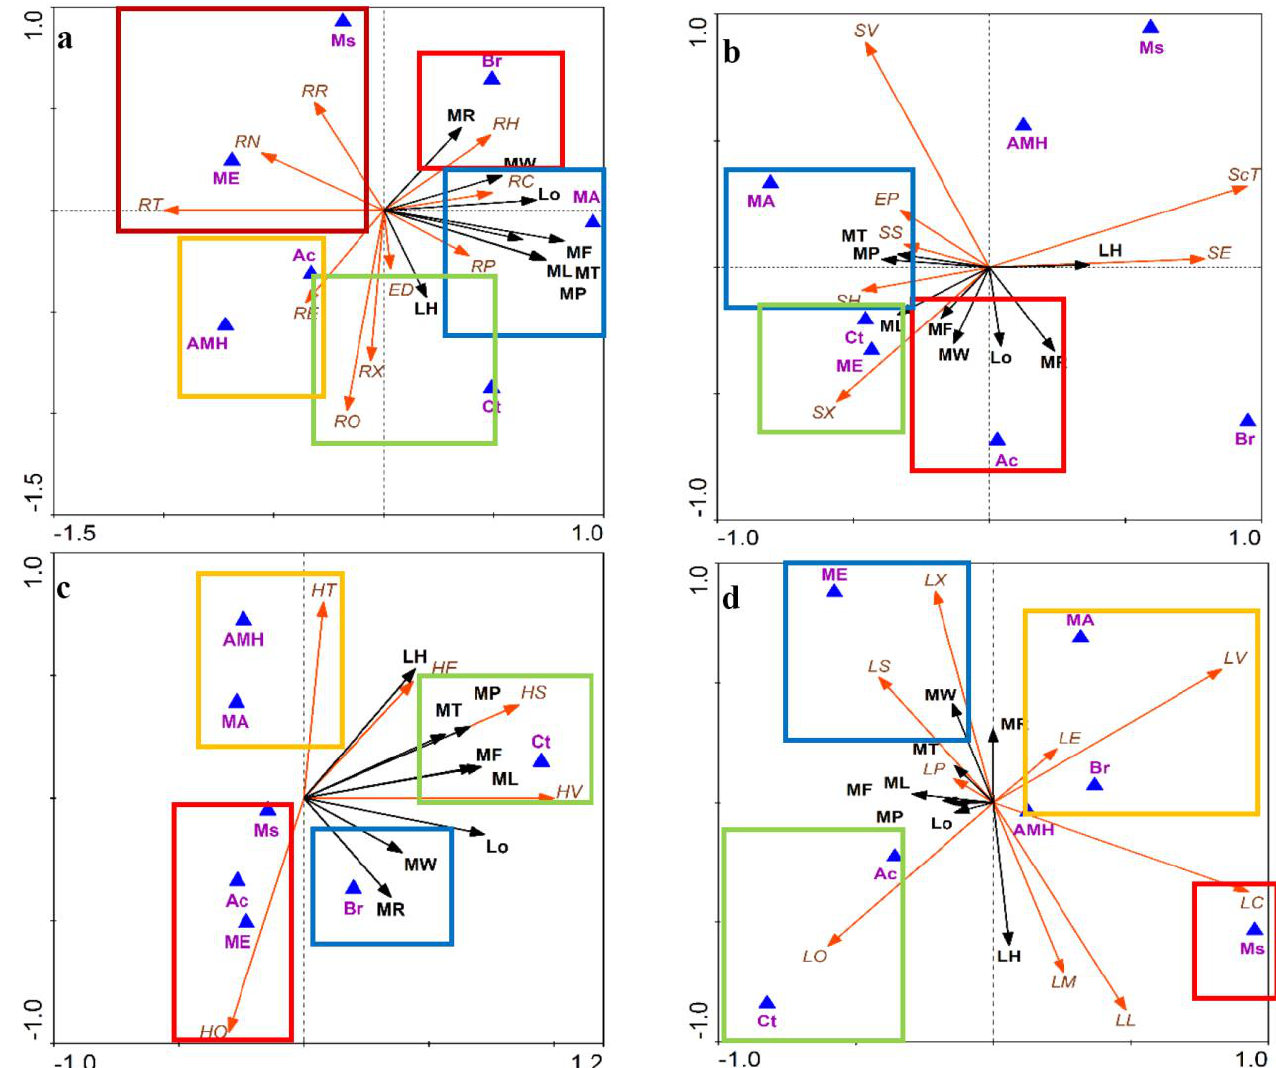
Figure 6. RDA triplot showing the response of morpho-anatomical characteristics in Dactyloctenium aegyptium to pre- and post-emergence herbicides. ( a ) Morphology and root anatomy, ( b ) Morphology and stem anatomy, ( c ) Morphology and leaf sheath anatomy, ( d ) Morphology and leaf blade anatomy. The colored rectangles represent grouping of variables with particular herbicides. For abbreviations please see list at the end of